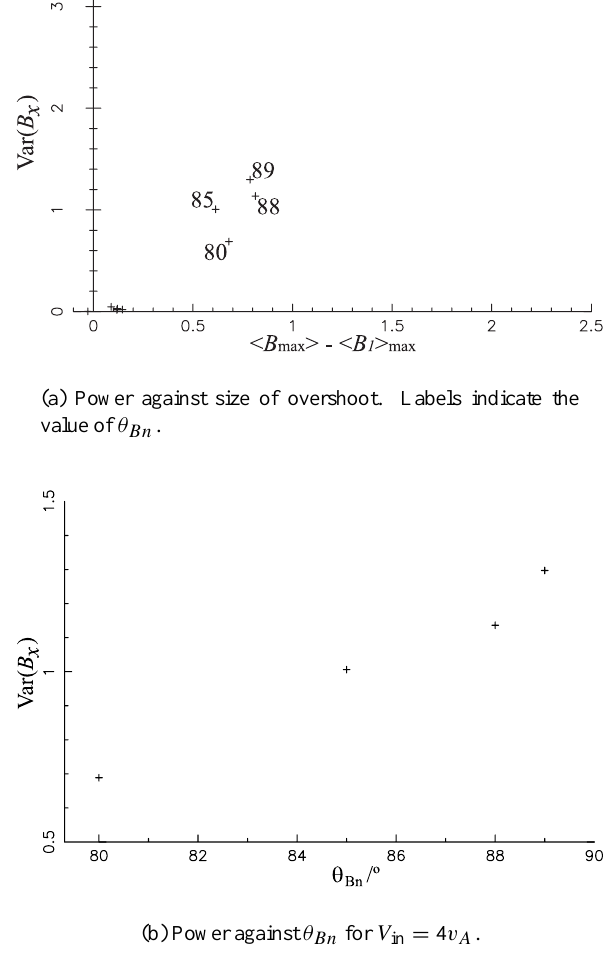
Fig. 7. Graphs showing how the power in the shock ripples in- creases with both the size of the overshoot and the value of the angle θ Bn